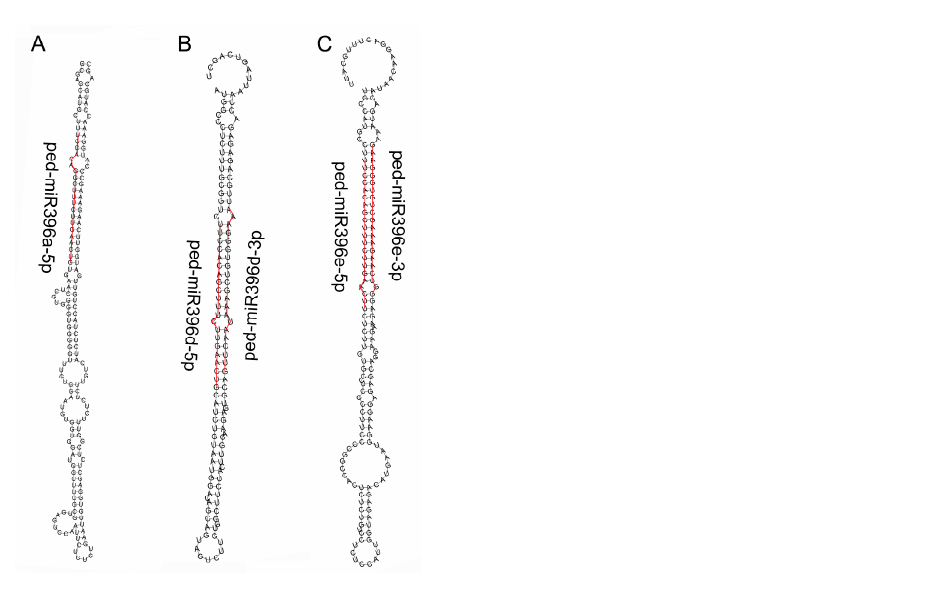
Figure 1. Secondary structures of the five miR396 members predicted using online software. The mature miR396 sequences are delineated by the red lines. ( A – C ) Predicted secondary structures of ped‑miR396a‑5p, ped‑miR396d‑5p, ped‑miR396d‑3p, ped‑miR396e‑5p, and ped‑miR396e‑3p. Five miRNAs were predicted to have 1285 target genes (Table S2). Of these target genes, 44 encoded transcription factors (TFs) of 14 families. Among these TF genes, 20 (45.45%) encoded GRFs, 4 (9.09%) encoded homeobox‑homeodomain‑leucine zipper (HB‑ HD‑ZIP), 4 (9.09%) encoded basic region/leucine zipper motif (bZIP), 3 (0.41%) encodedd MADS‑MIKC, 67 genes encode protein kinases (PKs), and 7 encoded transcription regula‑ tors